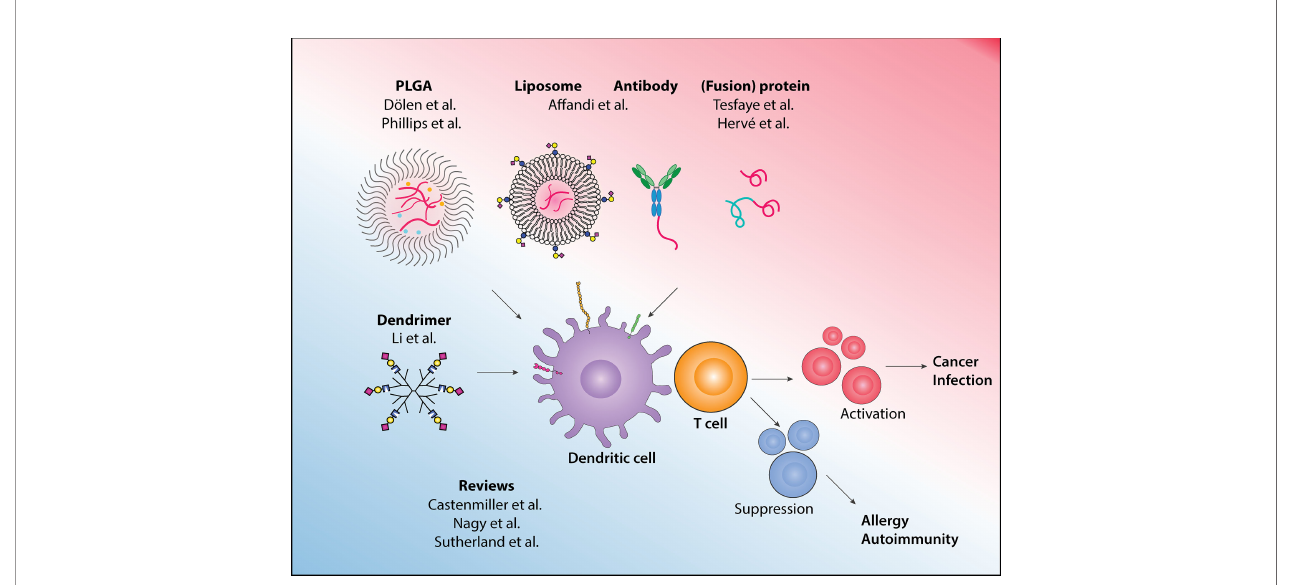
FIGURE 1 | In this Research Topic, various approaches to target antigens to dendritic cells for immunotherapy and to drive the appropriate immune responses are described, and the latest development and other emerging platforms in the fi eld are